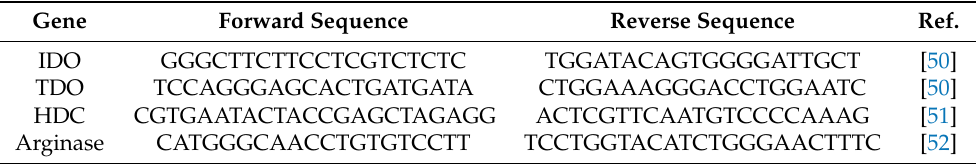
Table 3. Sequence of primers used in qRT-PCR